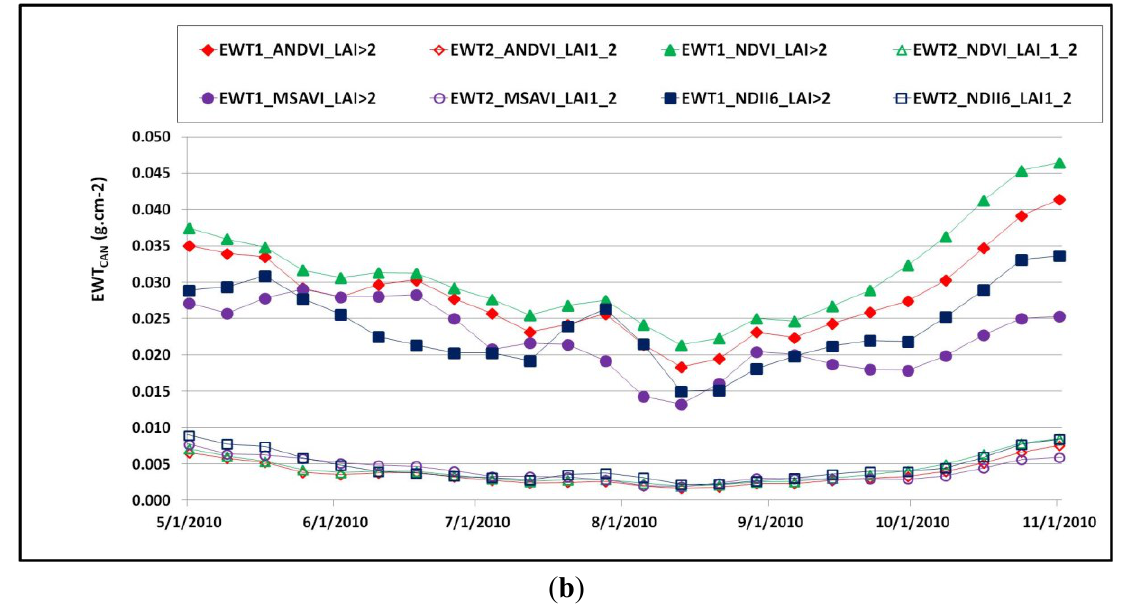
Figure 7. Time course profiles of EWT CAN as estimated from inversion models, MOD1 (EWT1) and MOD2 (EWT2), using the best performing VI over 2010 in the study region. ( a ) Comparison of MOD1 and MOD2 for herbaceous (LAI ≤ 1) and sparse vegetation (LAI between one and two); ( b ) comparison of MOD1 and MOD2 for sparse (LAI between one and two) and dense vegetation (LAI >